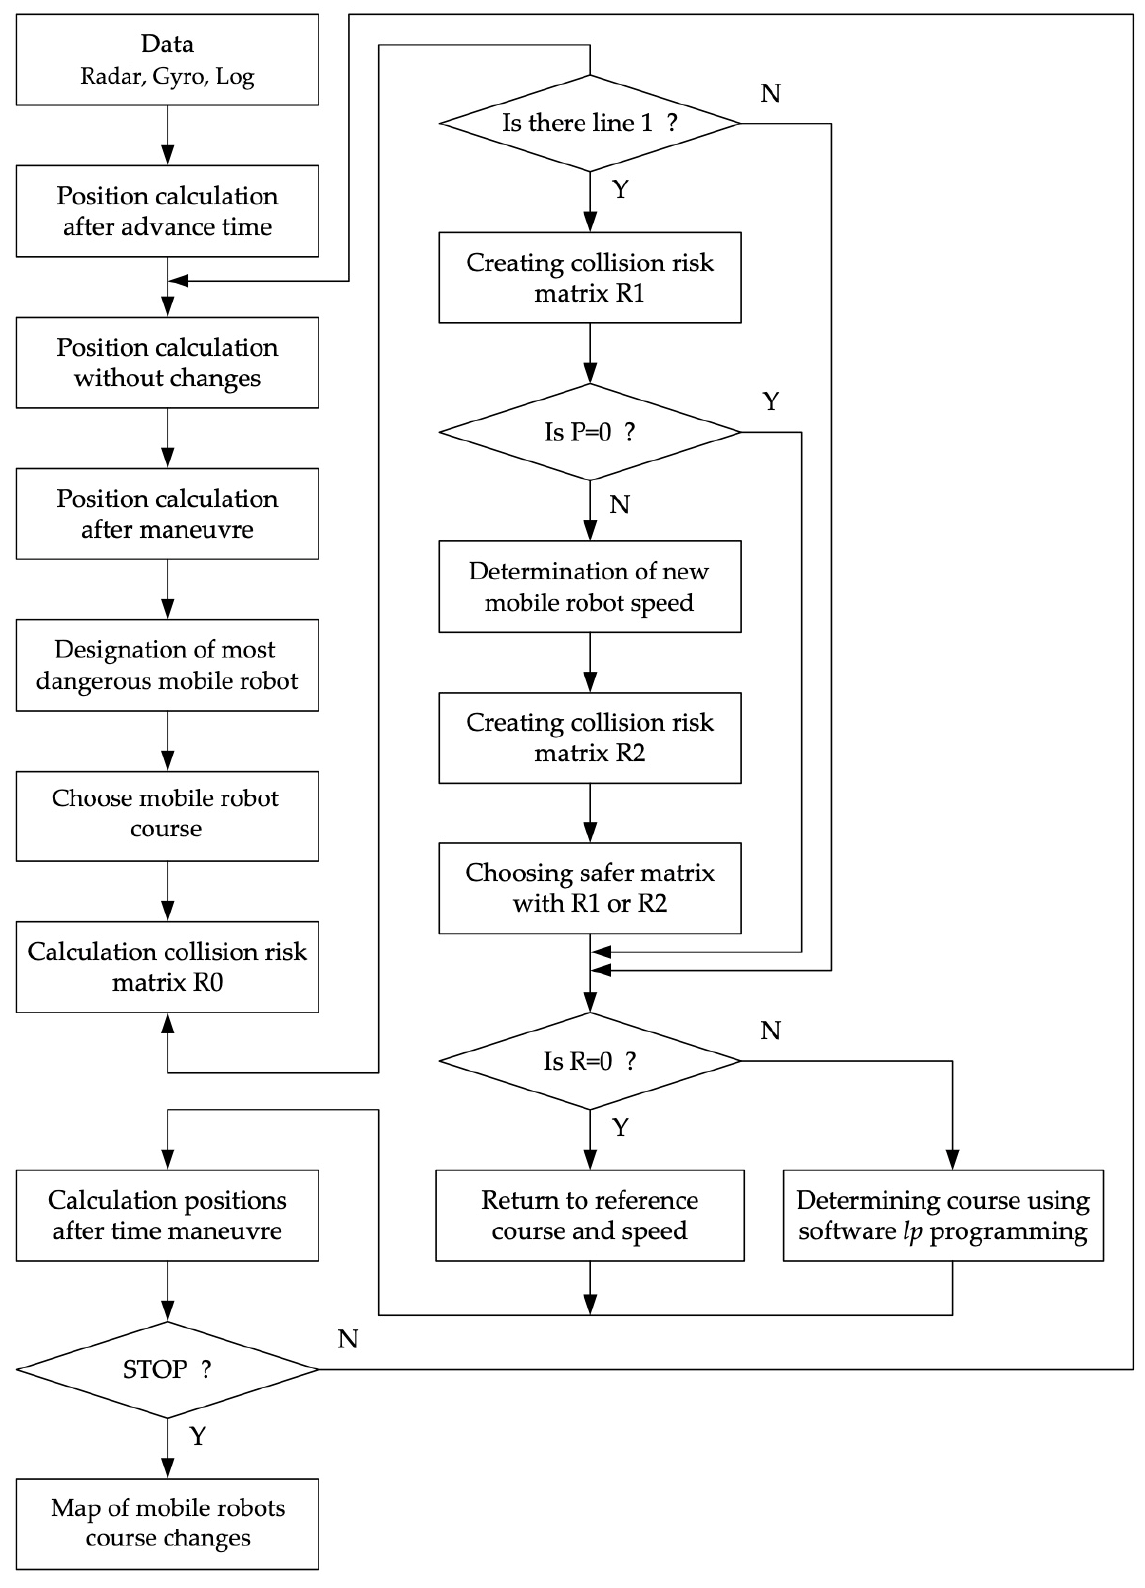
Figure 5. Block diagram of a multistage game control algorithm for a group of mobile robots.